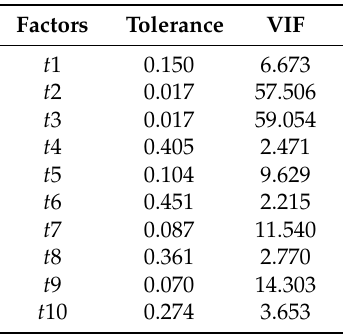
Table 4. Collinearity